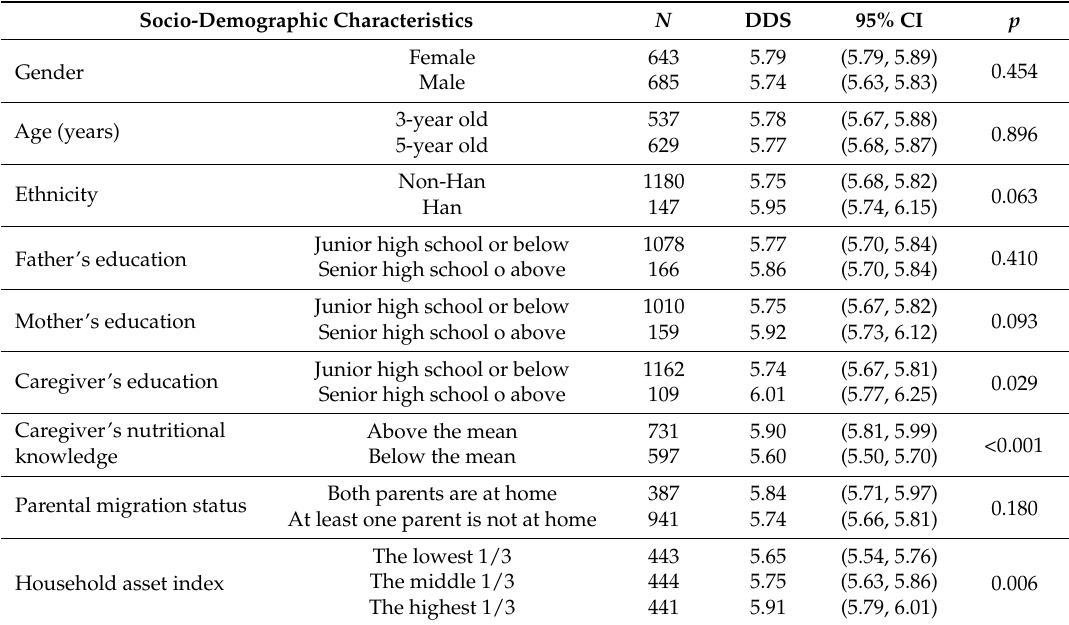
Table 2. The dietary diversity score (DDS) and preschooler’s socio-demographic characteristics.